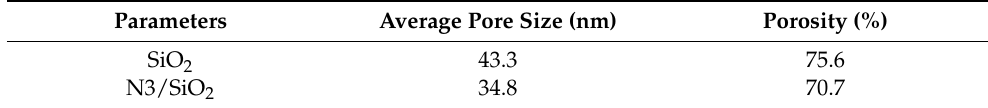
Table 1. The pore size and porosity of SiO 2 and N3/SiO 2